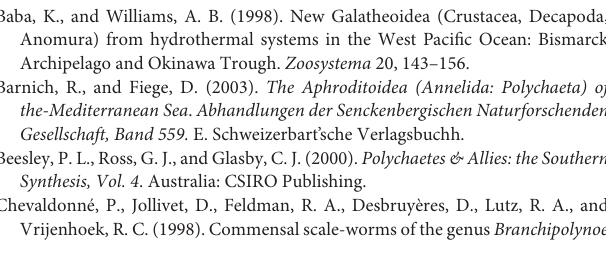
Supplementary Figure 1 | In situ photographs of polynoid individuals (marked by red circles) and their associated fauna in the Sakai Field of the Okinawa Trough.